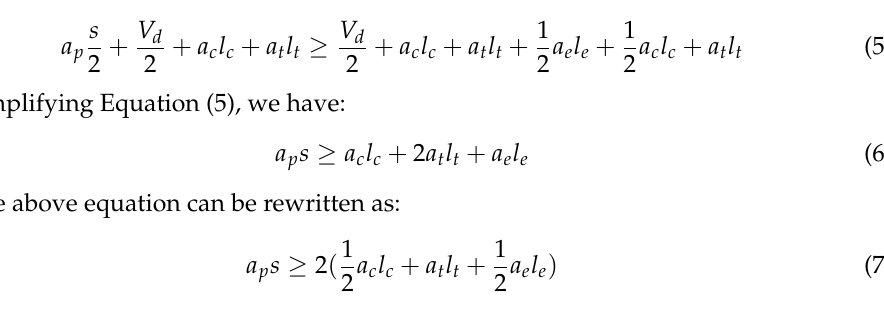
Figure 8. A schematic diagram of reciprocating-mechanism driven heat loop